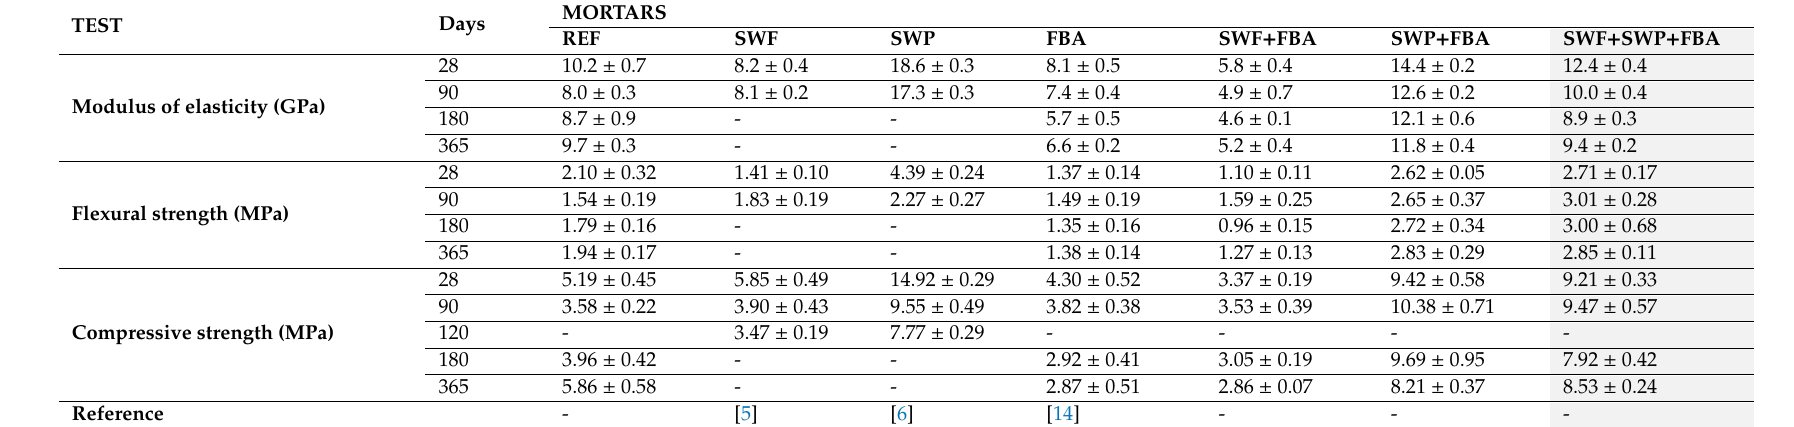
Table 3. Modulus of elasticity, flexural strength and compressive strength test